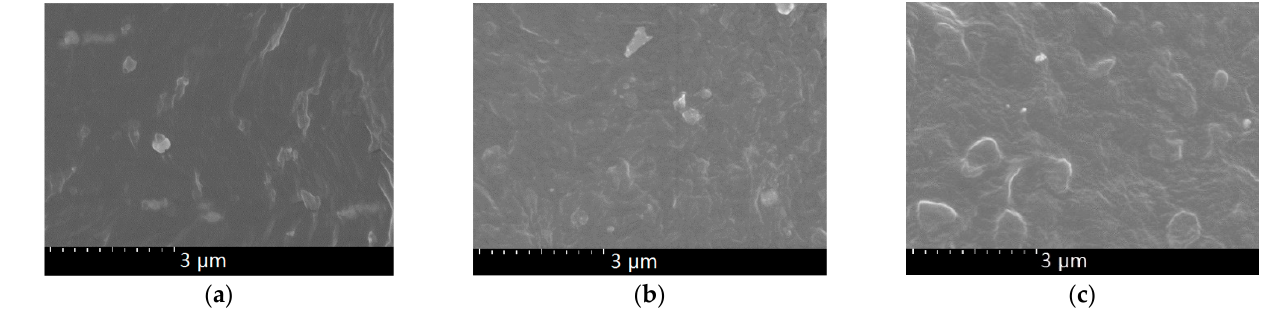
Figure 3. SEM of composite sections: ( a ) 2 wt%; ( b ) 2 wt% R-M; ( c ) 2 wt% H-M.